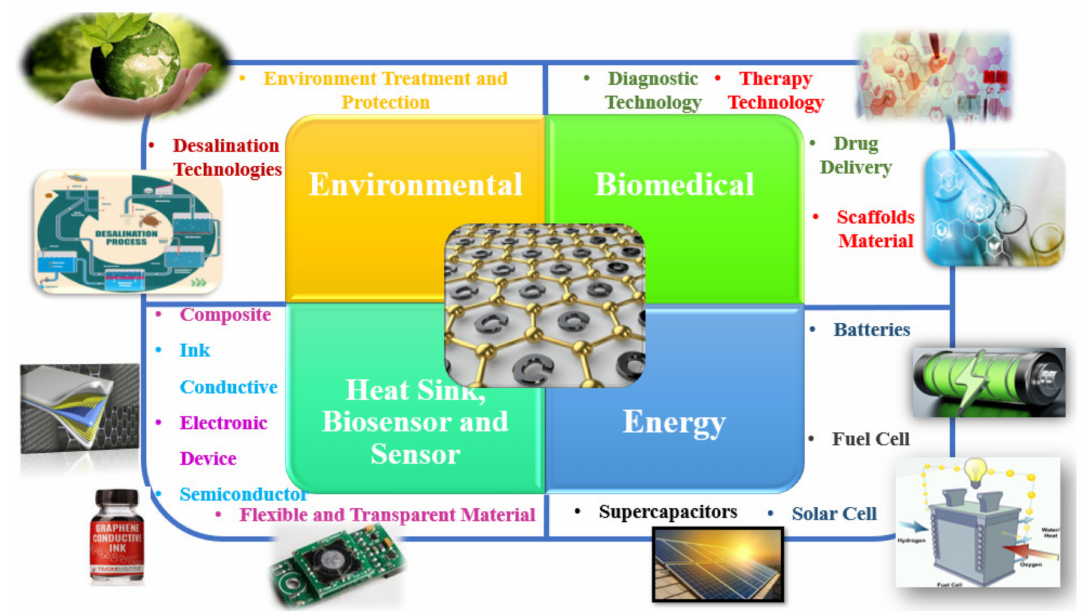
Figure 4. Multi-functional applications of graphene and its derivative based